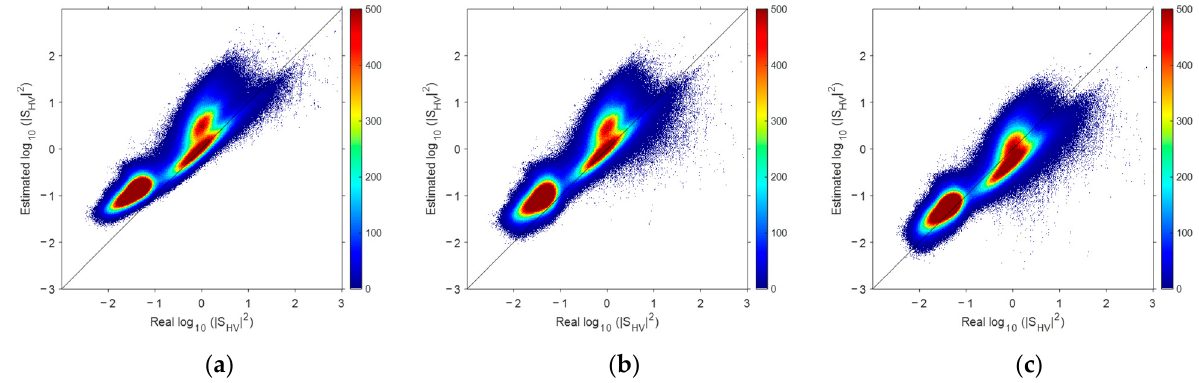
(cid:68) (cid:69) 2 S . ( a ) | S HV | 2 . ( a ) Souyris’ HV